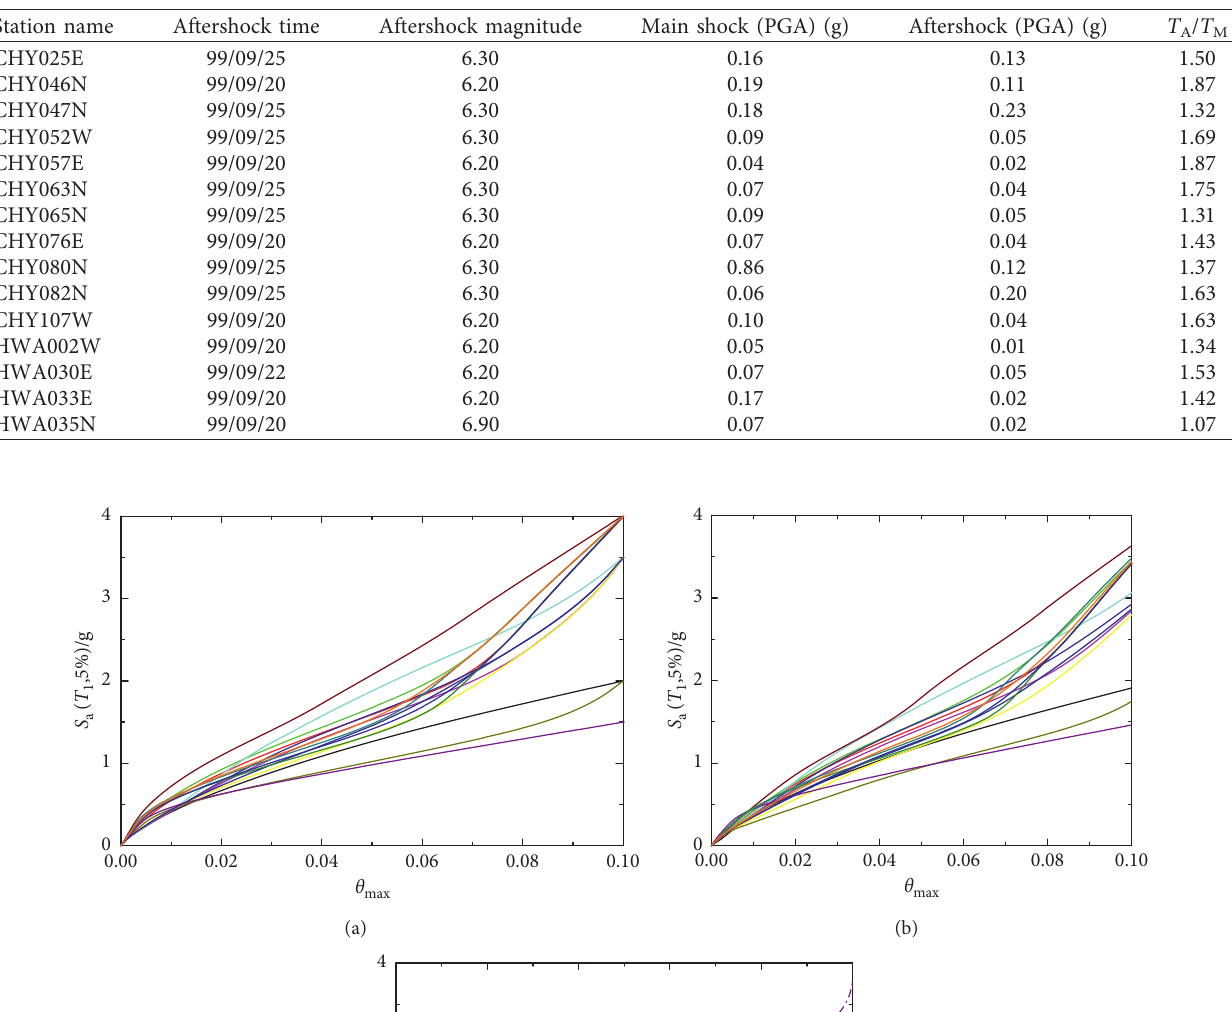
Table 4: Information of the main aftershock sequence ground